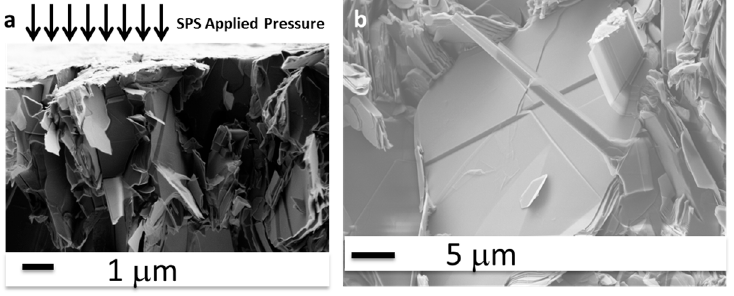
Figure 17. SEM performed on the bulk pellet: ( a ) Stacking of h-BN flakes; ( b ) Representative single flake.